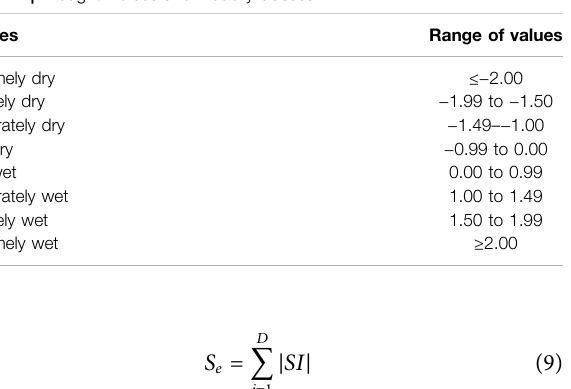
TABLE 1 | Drought indices and wet/dry